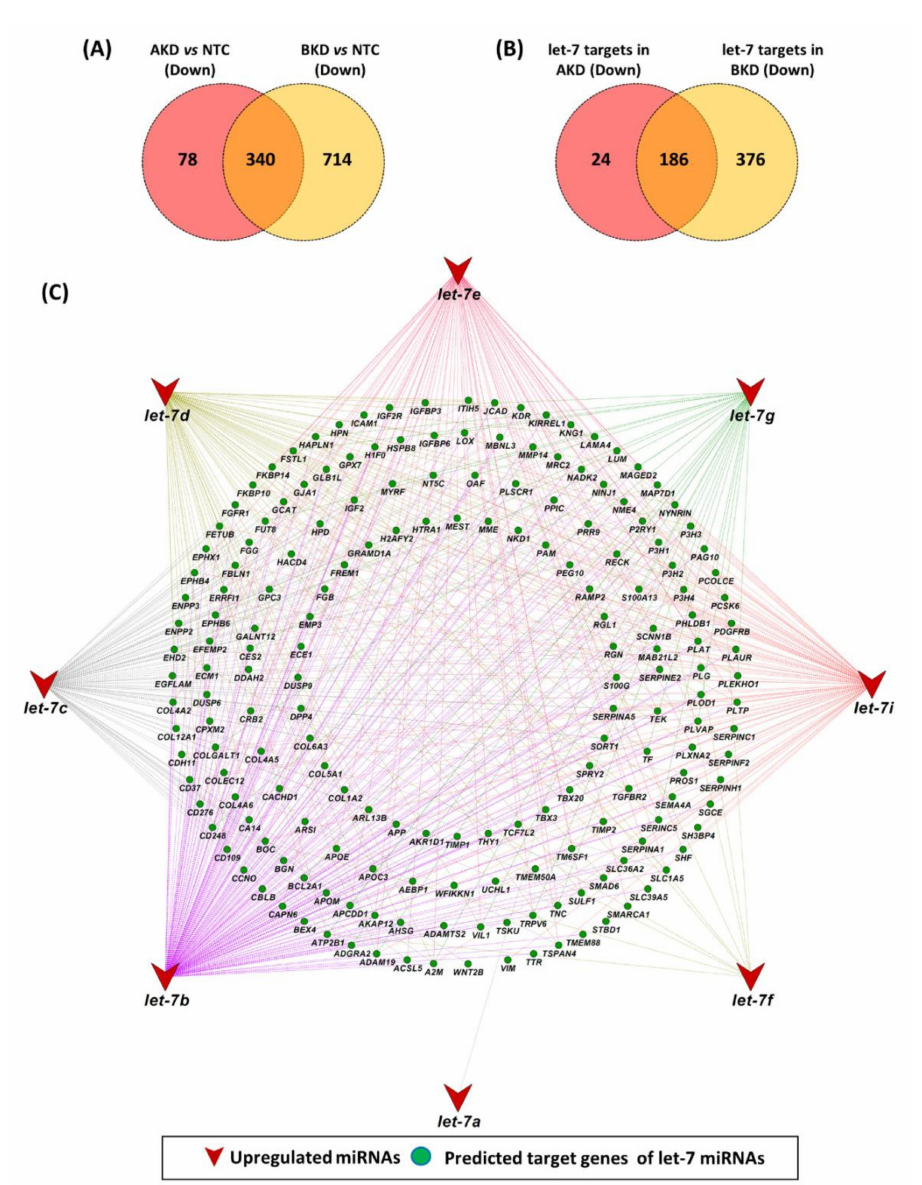
Figure 8. Downregulated target genes of let-7 miRNAs in AKD and BKD TE. Venn plots show ( A ) common downregulated genes and ( B ) common let-7 target genes in AKD and BKD TE. ( C ) miRNA- target gene network showing potential targets of each let-7